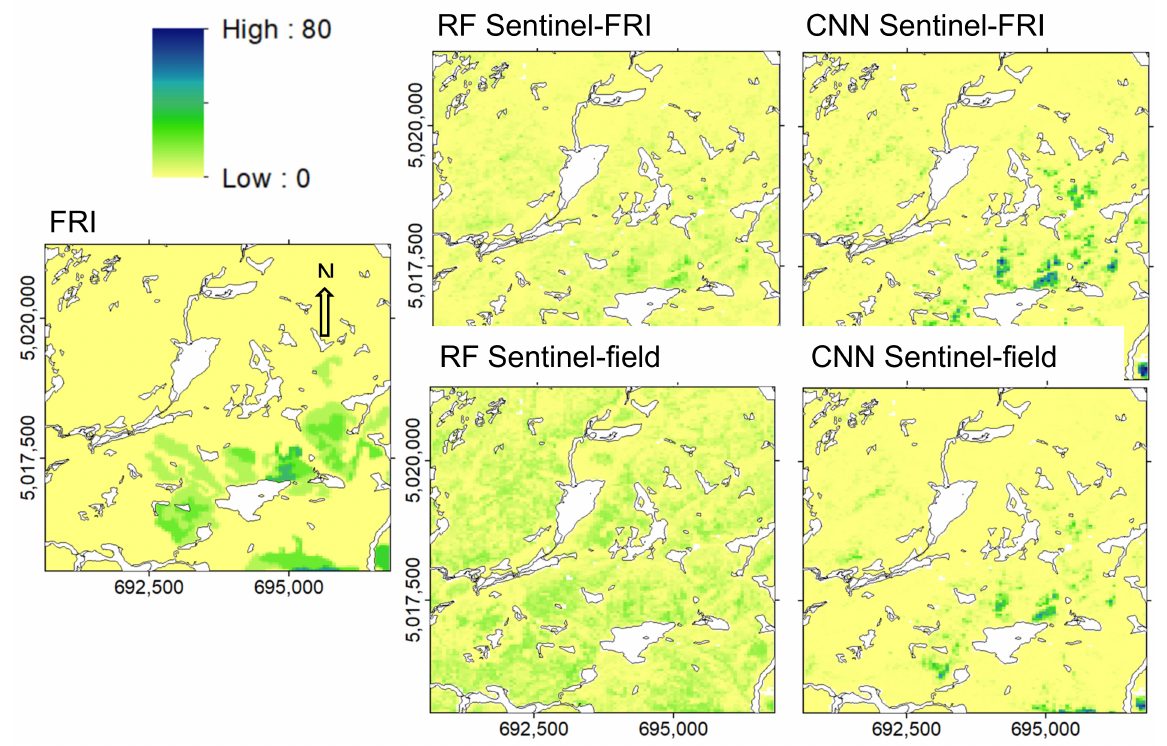
Figure 6. Map of the Depot Lake region of Haliburton Forest (UTM 17N, WGS84) showing percent abundance of red oak from the forest resource inventory (FRI) and from Sentinel-based predictions using either random forest (RF) or convolutional neural network (CNN) models trained with either FRI or field-based information (155 0.25-ha plots). White areas indicate lakes and